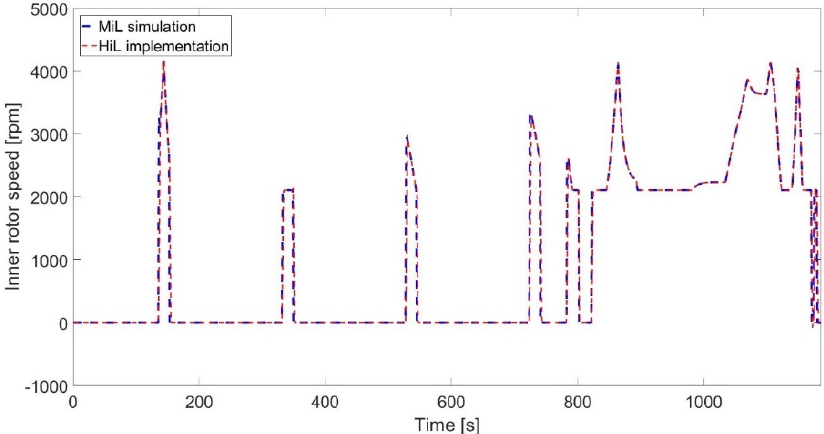
Figure 22. HiL (experimental) vs. MiL agreement results for the inner rotor speed, ECMS-based EMS.